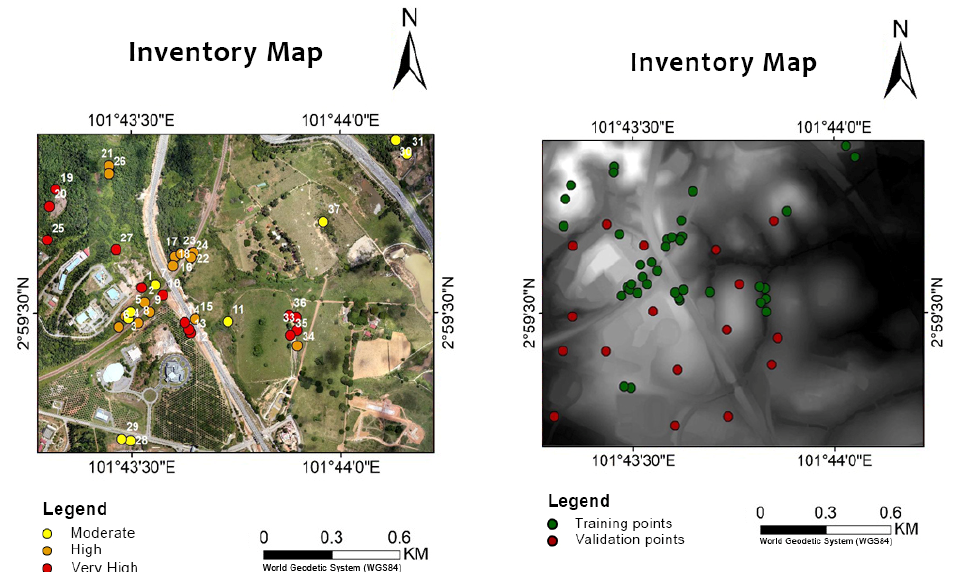
Figure 3. Landslide location map in LiDAR orthophoto ( left ) and Landslide location map in DEM map ( right ).